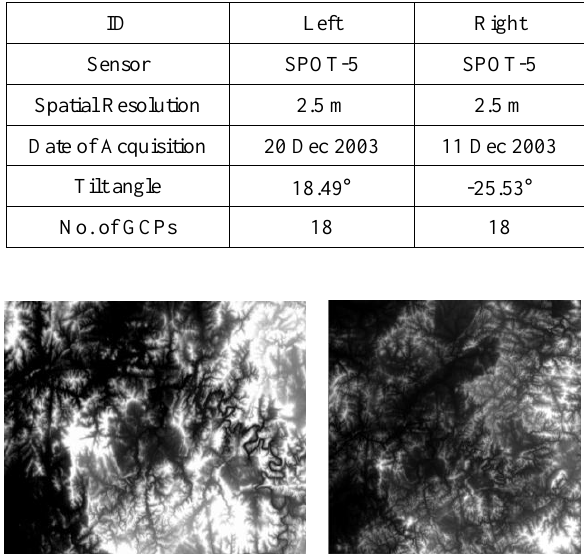
Figure 2. Two reference DEMs, one at 30m grid spacing(left) and DTED at 90m grid spacing(right).